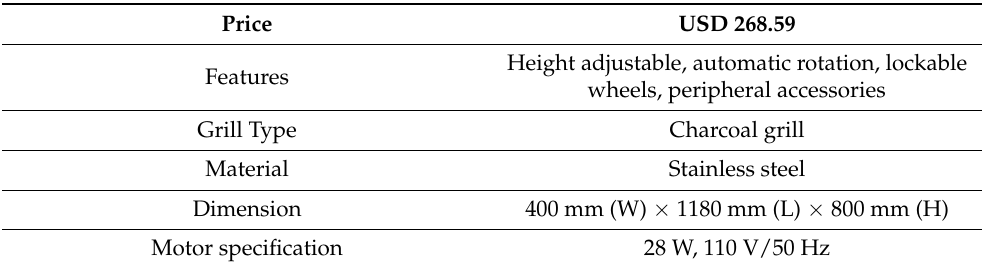
Table 1. Summary of the features and